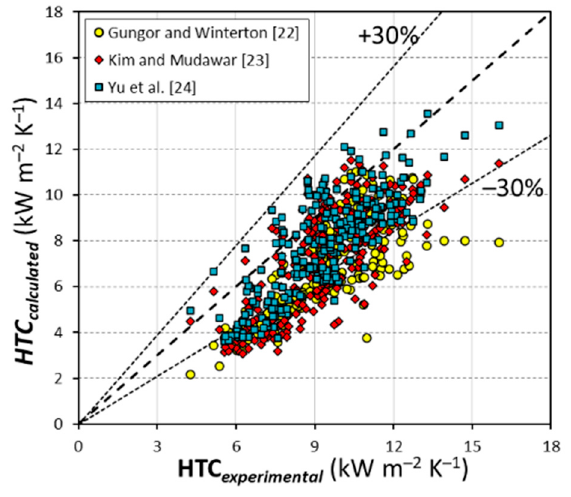
Figure 9. Comparison between calculated and experimental heat transfer coefficients.